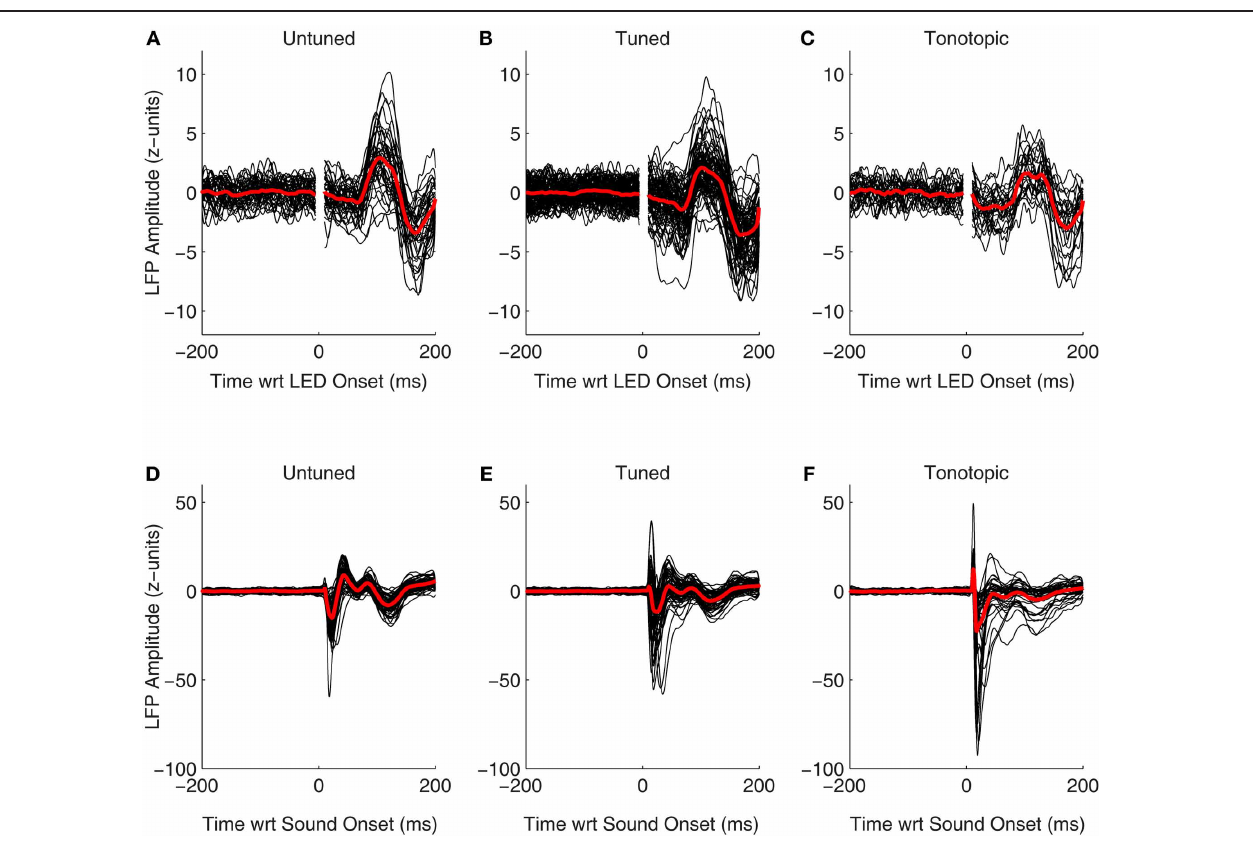
see Materials and Methods). For display, traces were smoothed by convolving the raw data with a 10ms Gaussian kernel normalized to sum to 1. The red traces indicate the mean of the responses, means were taken from the unsmoothed data.